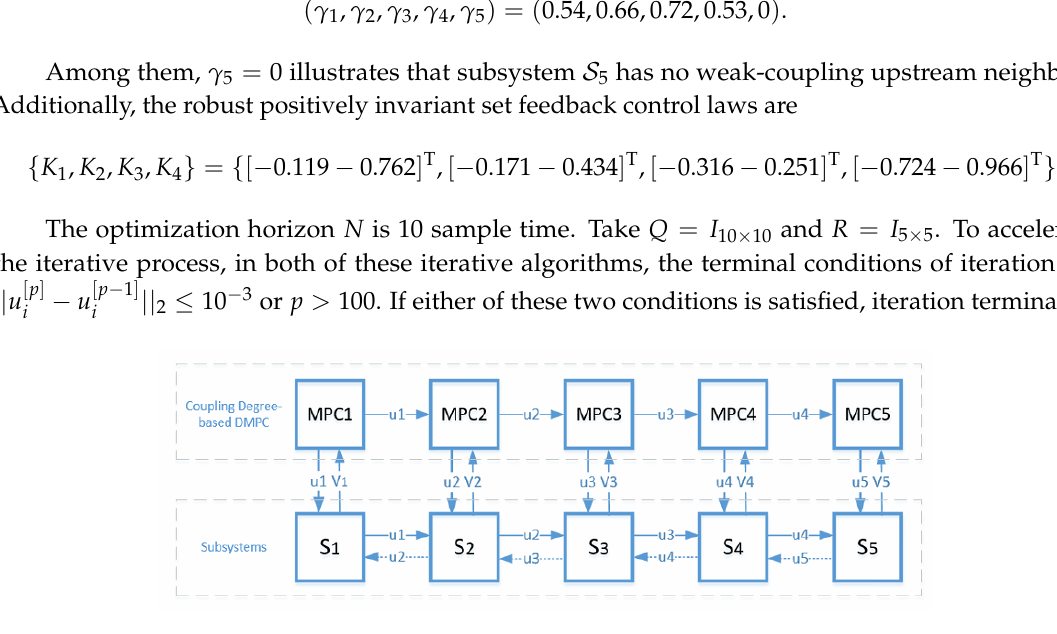
Figure 1. An illustration of the structure of a distributed system and its distributed control framework. MPC: model predictive control; DMPC: distributed